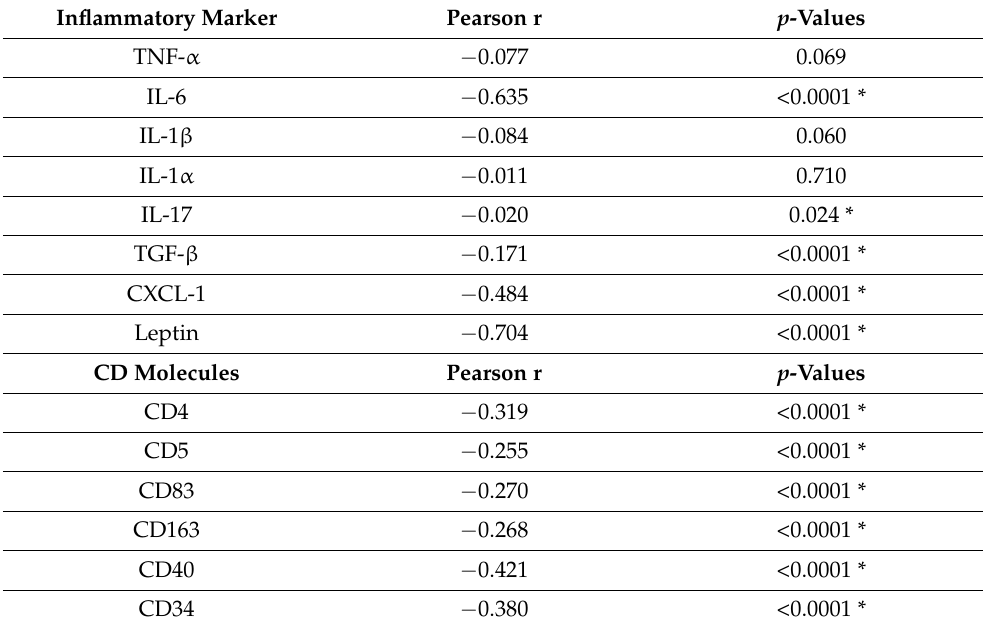
Table 1. Correlation of ER α expression with inflammatory cytokines. (* p < 0.05, statistically significant). Inflammatory Marker Pearson r p -Values TNF- α − 0.077 0.069 IL-6 − 0.635 <0.0001 * IL-1 β − 0.084 0.060 − 0.011 0.710 − 0.020